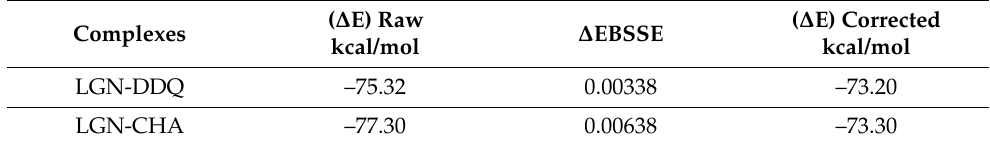
Table 1. Interaction energies without and with the BSSE (( ∆ E) raw , and ( ∆ E) corrected and ∆ EBSSE, respectively, in kcal mol − 1 at the B3LYP/6-311G(d,p) level of theory.